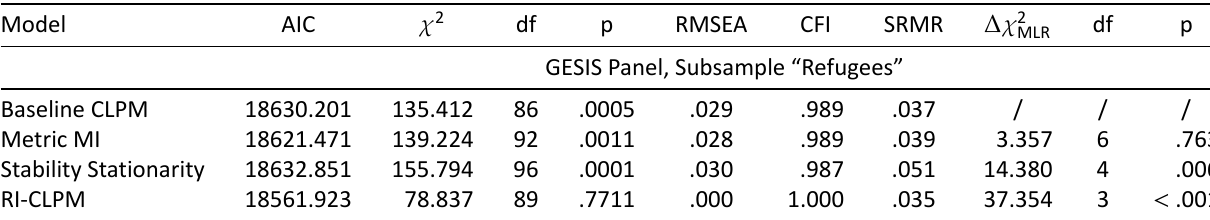
Table A1. Model fit indices of the (RI-)CLPM reported in